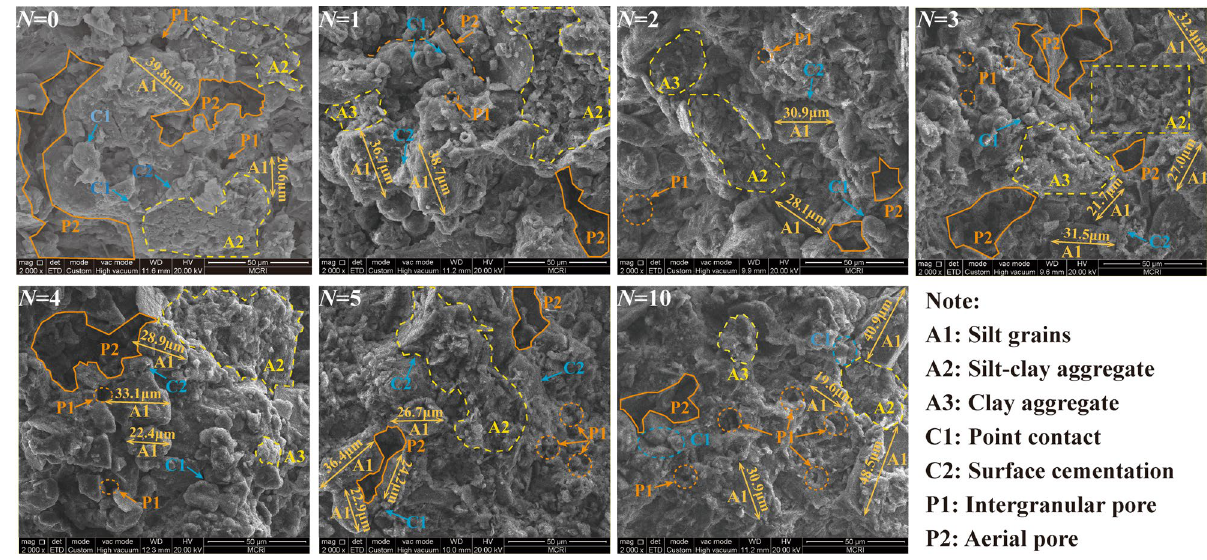
Figure 5. SEM images of RL under W–D cycles ( N ) (× 2000).